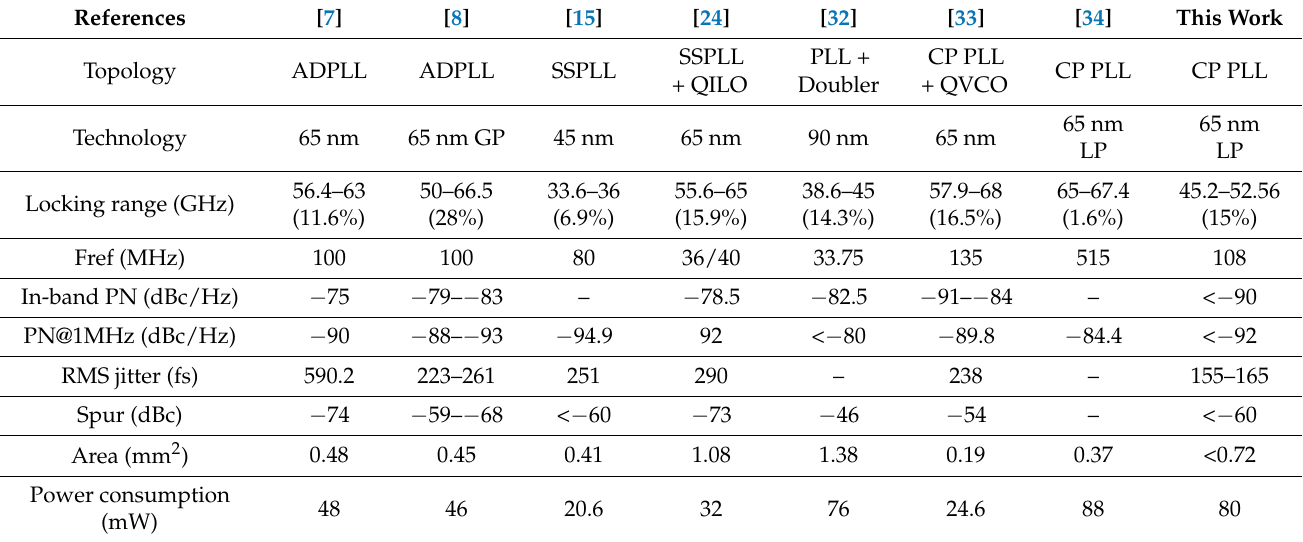
Table 4. Performance comparison with the state-of-the-art PLL for 60 GHz applications.